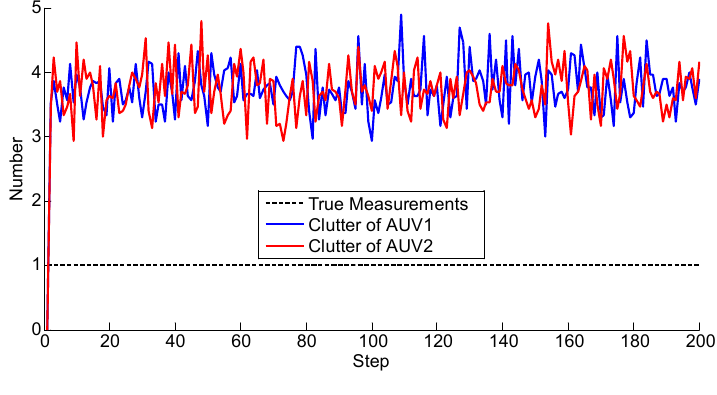
Figure 8. Number of the clutter